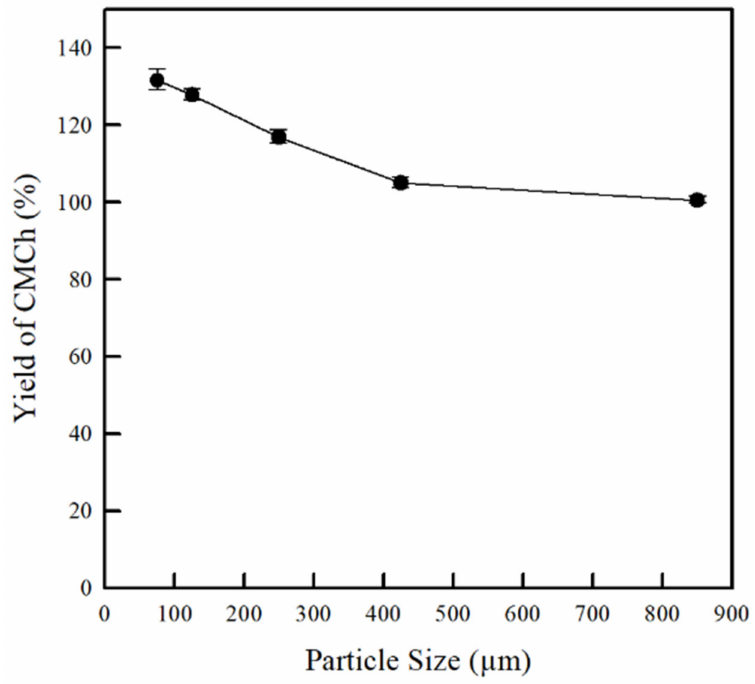
Figure 4. Effect of chitosan particle sizes on yield of CMCh